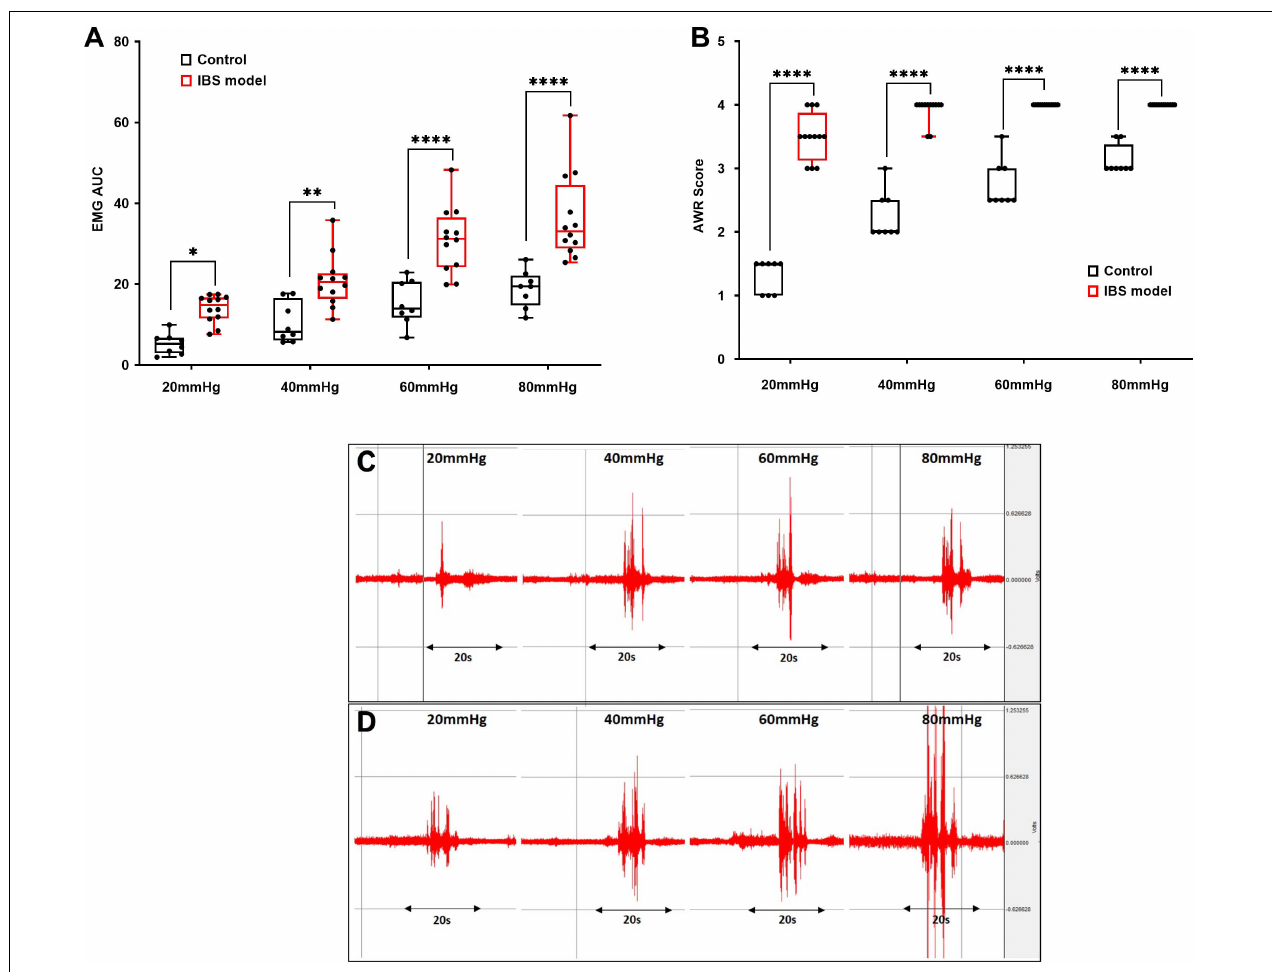
FIGURE 2 | Validation of animal model of visceral hypersensitivity (IBS model). EMG and AWR were assessed using colorectal distention test in hypersensitive ( n = 12) and control (normal) rats ( n = 8). (A,C,D) EMG in acetic acid-treated rats were significantly higher at 20, 40, 60, and 80 mmHg than control (* p <